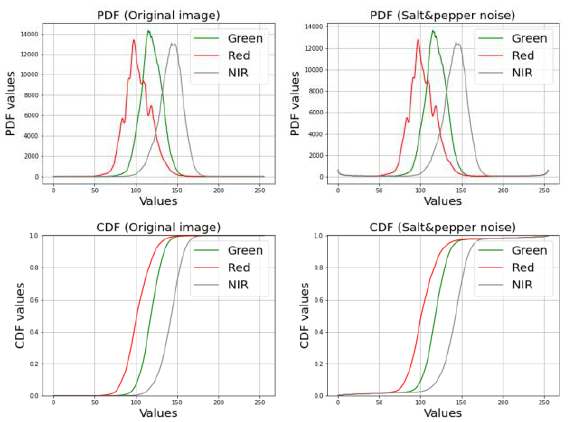
Figure 9. PDF and CDF for original image and salt & pepper noise augmented image.